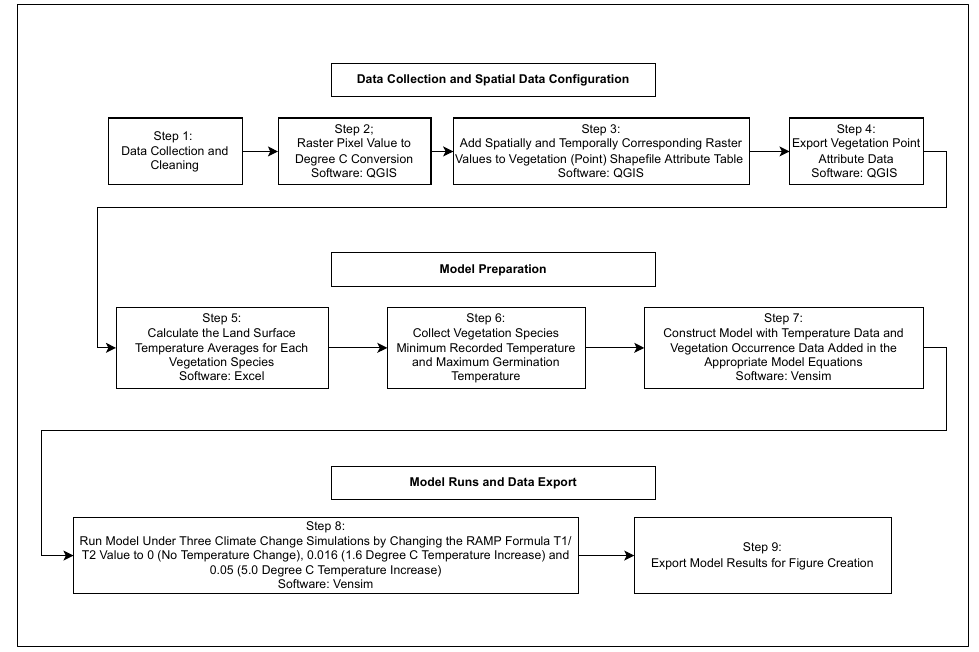
Figure 1. Methodology Workflow Diagram.